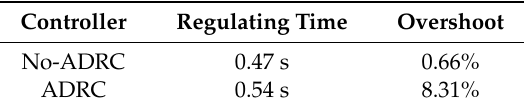
Table 5. Simulation results of pitch